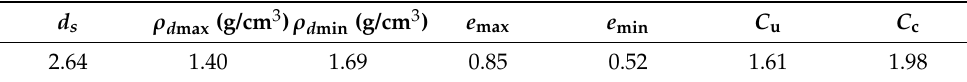
Figure 1. Particle size distribution of the sand sample. Table 1. The parameters of the sand sample.